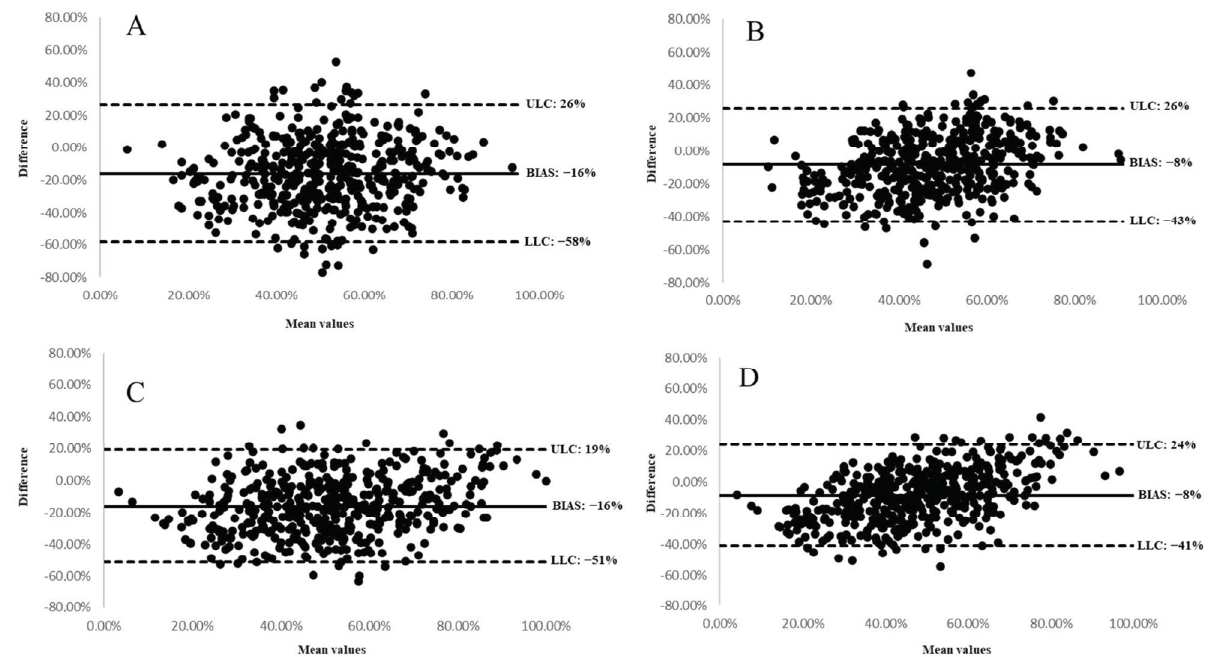
Figure 1. Bland-Altman plots between the BALANCE DI, the New BALANCE DI and both primary and secondary AHA-DS for determining overall diet quality of patients after myocardial infarction ( n = 473). ( A ) BALANCE DI and primary AHA-DS; ( B ) BALANCE DI and total AHA-DS; ( C ) New BALANCE DI and primary AHA-DS; ( D ) New BALANCE DI and total AHA-DS. The solid line repre- sents the mean difference between the two instruments, and the dotted lines represent the minimum and maximum differences between the scores. ULC: upper limit of concordance; LLC: lower limit of